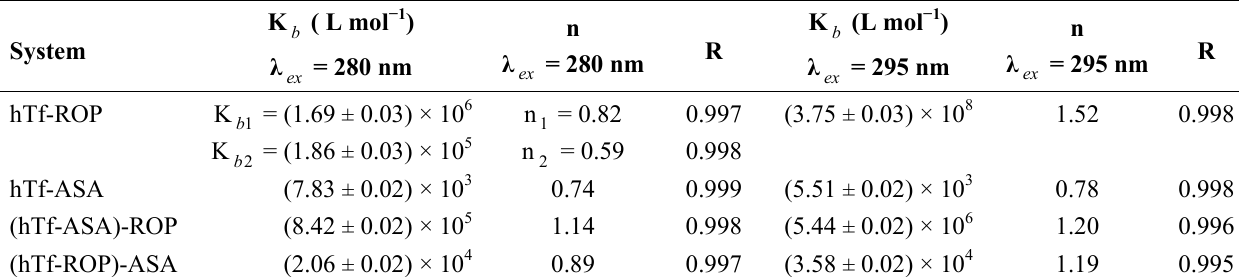
Table 2. The binding constants (K and ternary systems at pH = 7.4 and T = 298